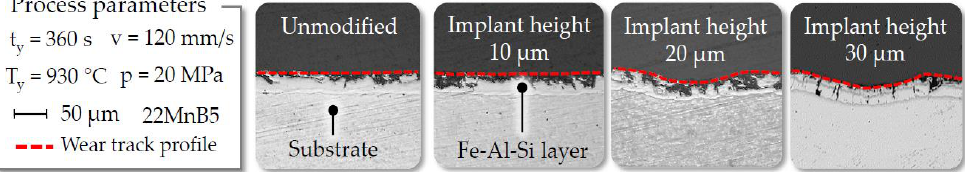
Figure 14. Cross-sectional preparations of the wear tracks.